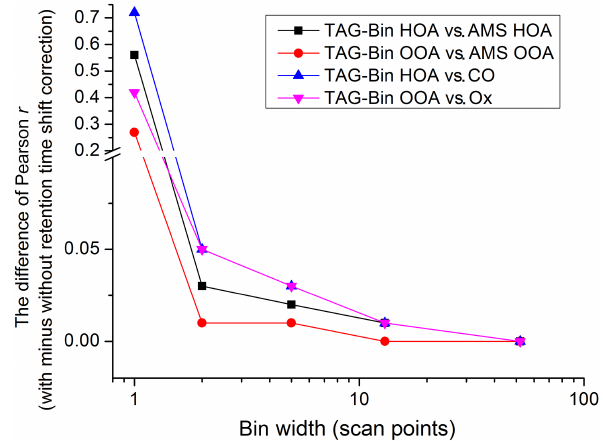
Figure 3. Median values of retention time shifts with respect to the first sample. The positive median value means the chromato- graphic peaks shift to the right of the first sample (the elution runs slower), whereas the negative value means peaks shift to the left (faster elution). The range of median shifts among all samples dur- ing the study period is 13 scan points.